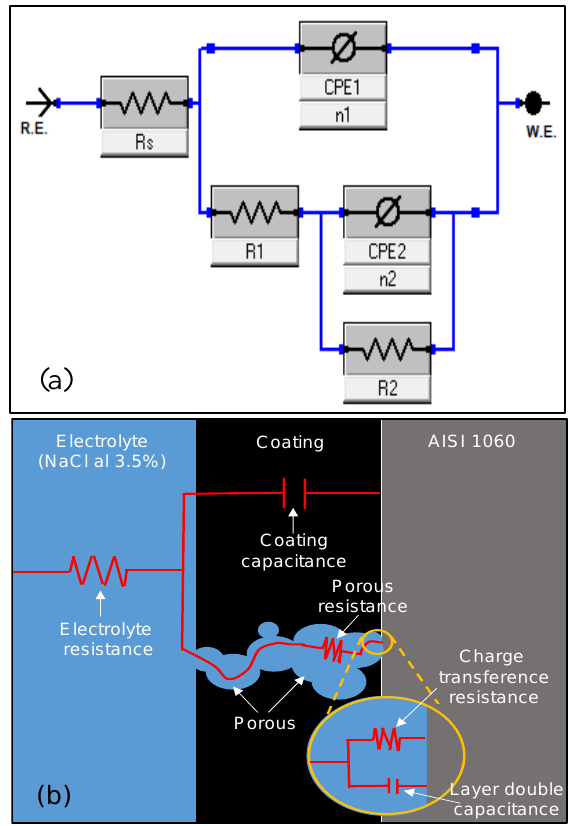
Figure 9. Schematic of a standard equivalent circuit model (Randles circuit) ( a ), and impedance simulated of the coating system ( b ).